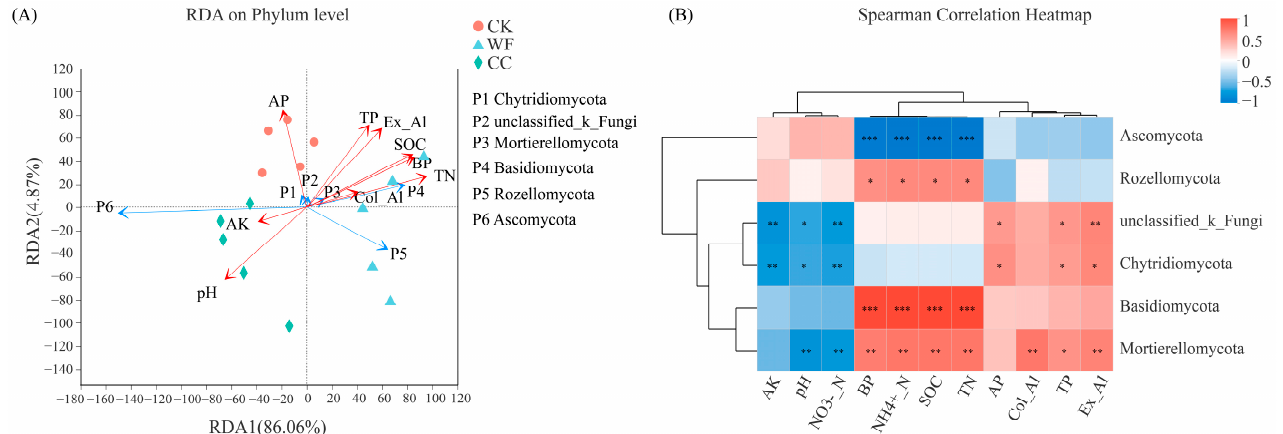
Figure 5. ( A ) Redundancy analysis (RDA) of the abundant fungal phyla and soil physicochemical characteristics. ( B ) The heatmap based on Spearman’s correlation analysis between fungal phyla and physicochemical variables. The significant correlations are denoted by asterisks (* p < 0.05; ** p < 0.01; *** p < 0.001).